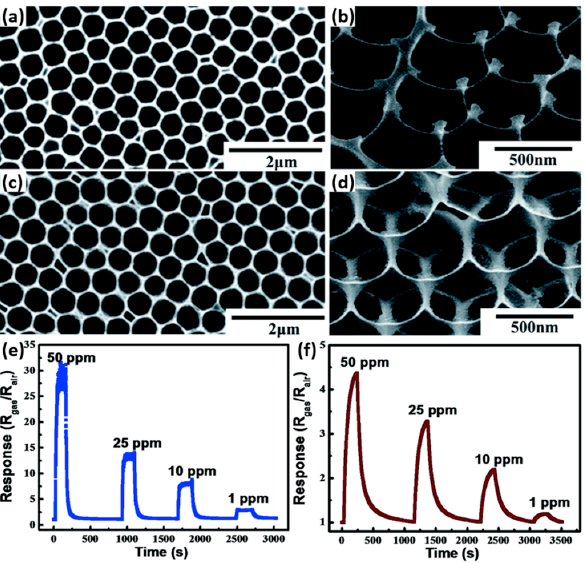
Figure 33. SEM images of ( a , b ) bowl-like ZnO micro/nanoporous arrays and ( c , d ) close-network ZnO micro/nanoporous arrays. Dynamic response and recovery curve of ( e ) close-network ZnO micro/nanoprous arrays and ( f ) bowl-like ZnO micro/nanoprous arrays towards NO 2 gas at room temperature under UV light irradiation. Reproduced with permission from [63].